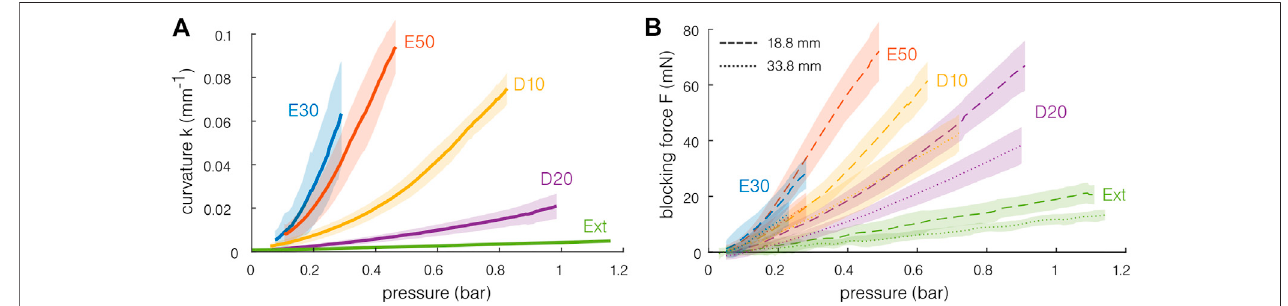
FIGURE5| Quasi-staticmechanicalcapabilitiesoftheactuatorfordifferentmaterials.Theshadedregionindicatesthestandarddeviation. (A) Thesoftestactuators achieveacurvatureofabove 0.07 mm − 1 for pressureinferiorto1 bar.Acurvatureof0.1 mm − 1 corresponds toaradiusofcurvatureof10 mmand toabending angleof approximately 180 ° for an actuator of 30 mm. (B) The blocking forceis measured for two different freelengths (18.8 and 38.8 mm). The maximal blocking forces remain inferior to 100 mN. The stiffer the material, the lesser the force exerted for a given